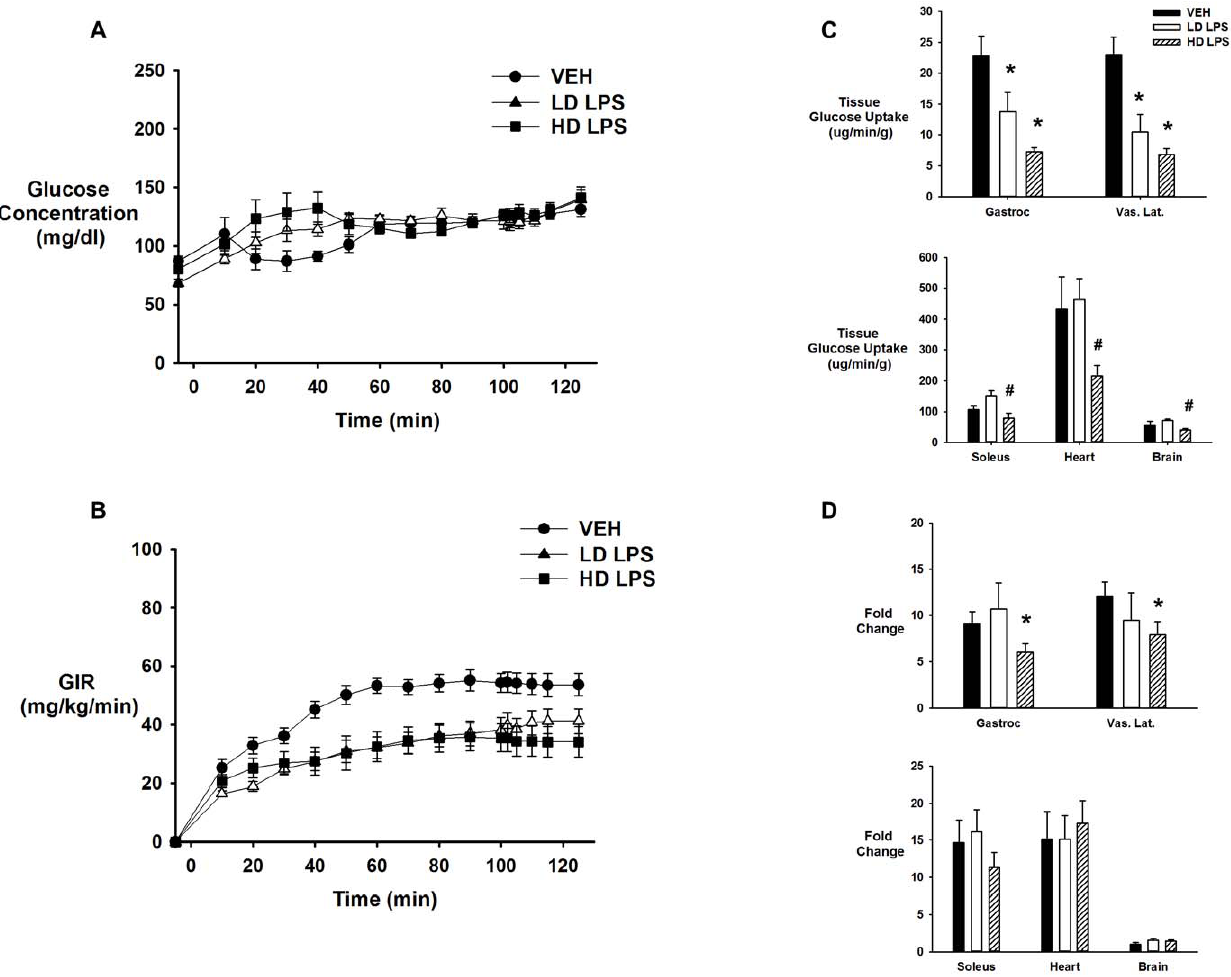
Figure 4. Glucose concentrations and insulin-stimulated tissue glucose uptake following vehicle and LPS treatment. Arterial glucose concentrations (Panel A); glucose infusion rate (GIR; Panel B) and tissue (soleus, gastrocnemius, superficial vastus lateralis (SVL), heart, and brain) glucose uptake (Panel C), and fold-change from basal of insulin-stimulated glucose uptake (Panel D) during a hyperinsulinemic-euglycemic clamp in chronically catheterized 5-hour fasted C57/BL6j mice that received vehicle (VEH), low-dose LPS (LD LPS; 1 m g/gBW), or high-dose LPS (HD LPS; 10 m g/ gBW),. Data are expressed as mean 6 SEM. * p , 0.05 vs. VEH, # p , 0.05 vs. LD LPS.